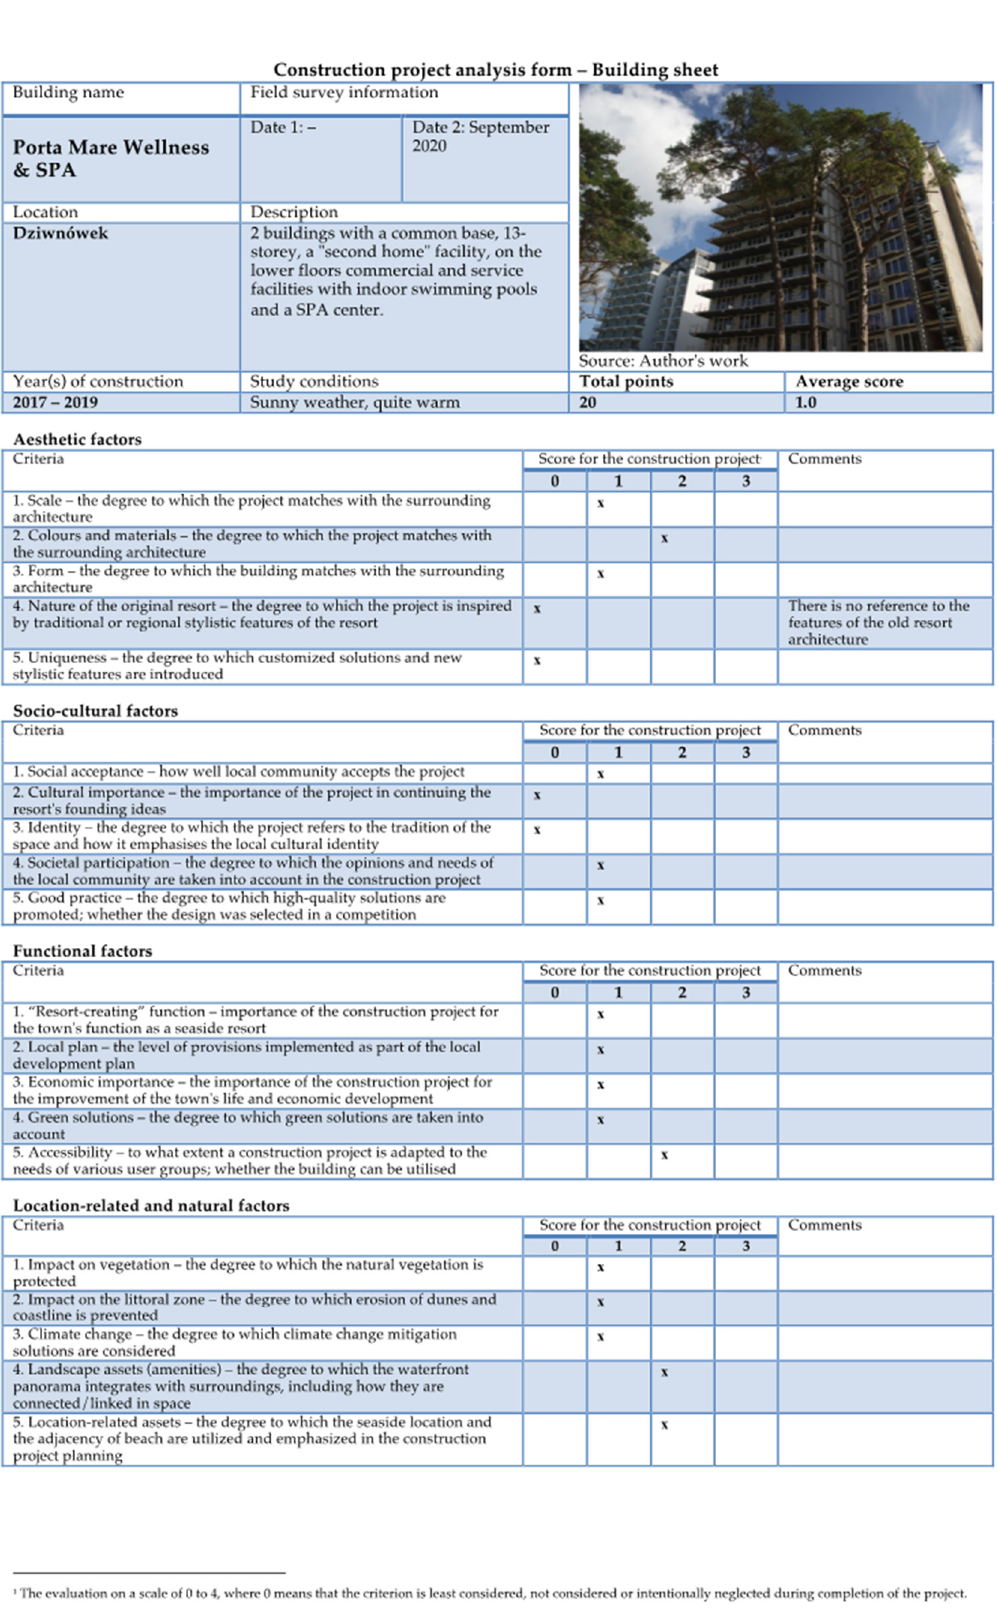
Figure A9 . Porta Mare Wellness & SPA in Dziwnówek. Building sheet. Figure A9. Porta Mare Wellness & SPA in Dziwn ó wek. Building